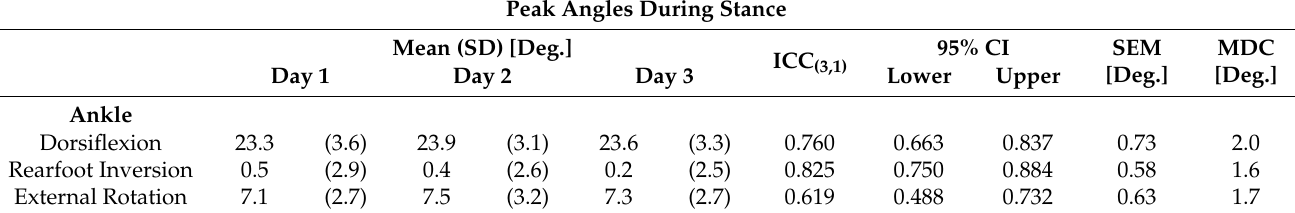
Table 4. Reliability of peak joint angles during stance across three distinct sessions and three distinct speeds in 21